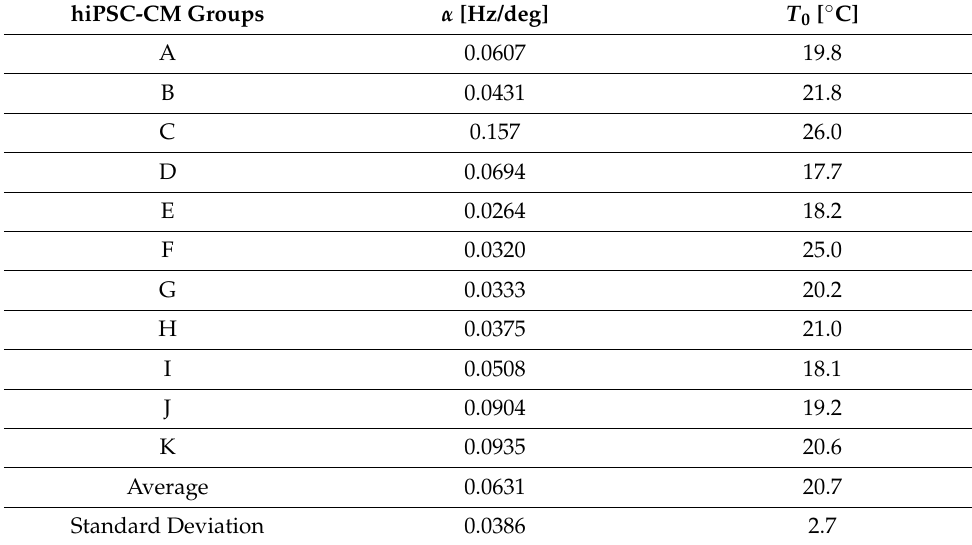
Table 1. Temperature dependence of the beating frequency of hiPSC-CM groups. The coefficients are shown when the temperature is T [ ◦ C], the beating frequency is f [Hz], and the relationship between the two is expressed as f ( T ) = α ( T − T 0 ) . The pulsation stop temperature T 0 [ ◦ C] calculated according to this relationship is also